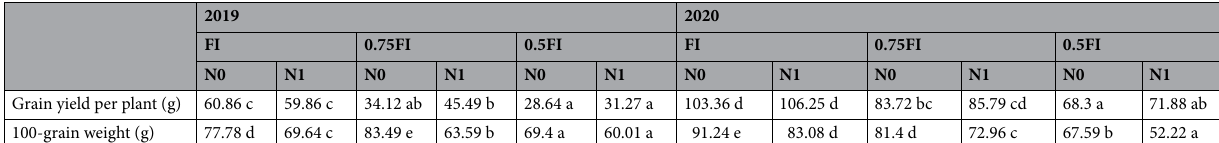
Table 4. The effects of irrigation regime and nitrogen fertilizer on grain yield per plant, water use efficiency and water productivity in pea. FI, full irrigation; N, nitrogen. Means with different letters did differ significantly.